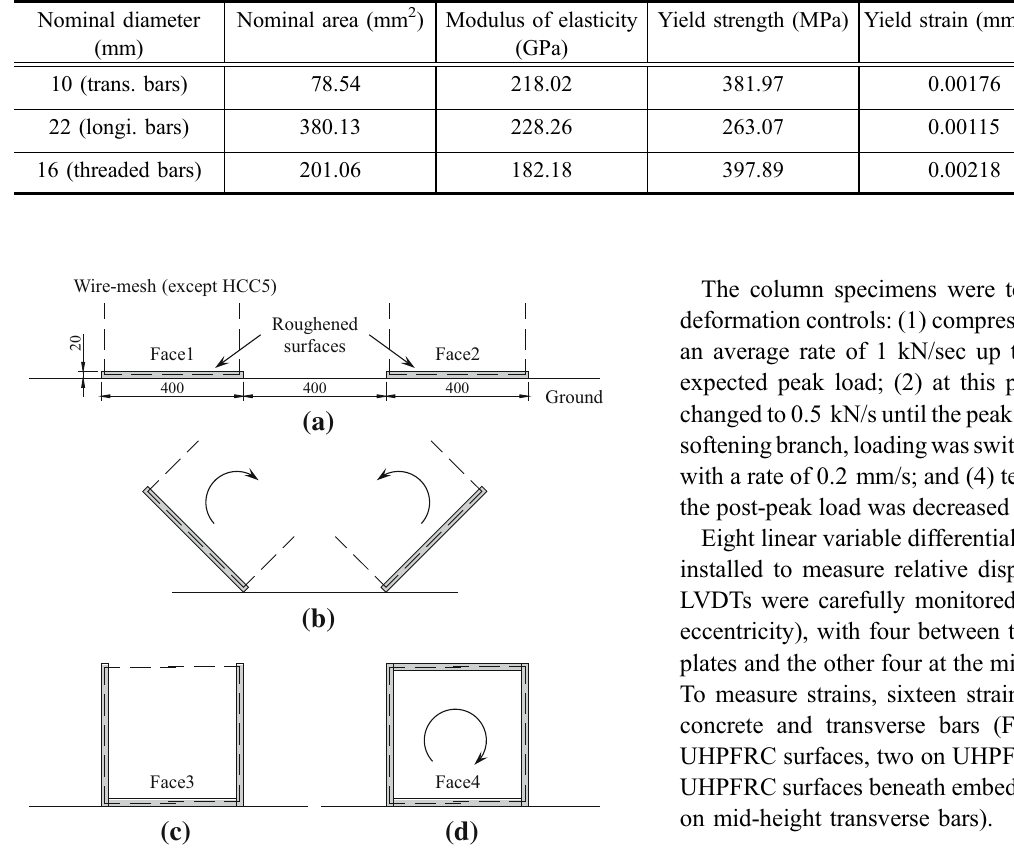
Fig. 4 Production sequence of UHPFRC tube (units: mm): a Step1 (Face1 and Face2), b Step2 (90 (cid:3) rotation), c Step3 (Face3), and d Step4 (180 (cid:3) rotation, Face4).